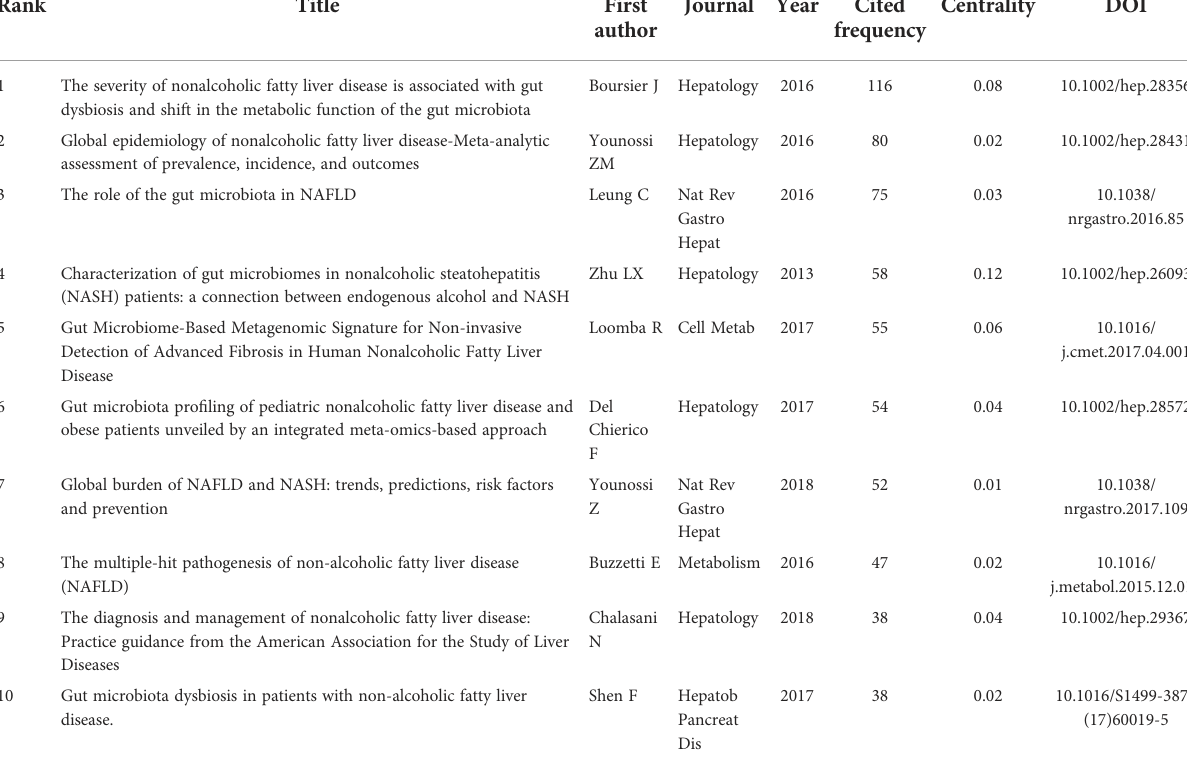
TABLE 4 The top 10 high cited references of 707 retrieved articles in the links of gut microbiota and MAFLD research from 2002 to 2021.